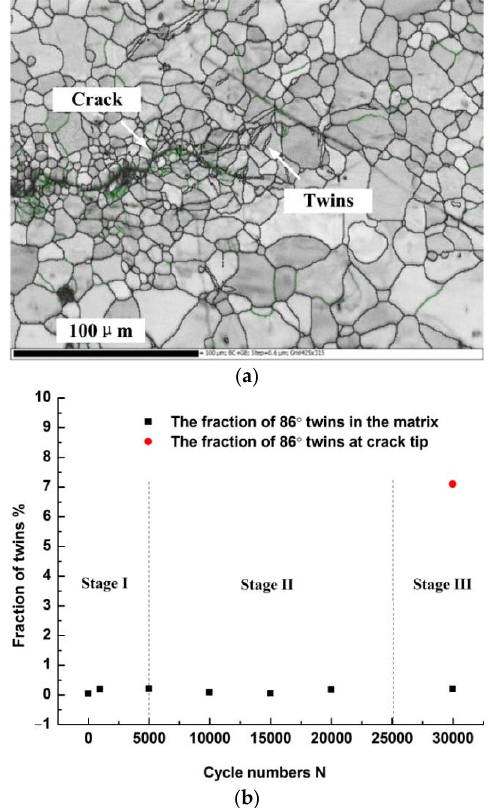
Figure 8. ( a ) The microstructure at the crack tip; ( b ) The content of 86°